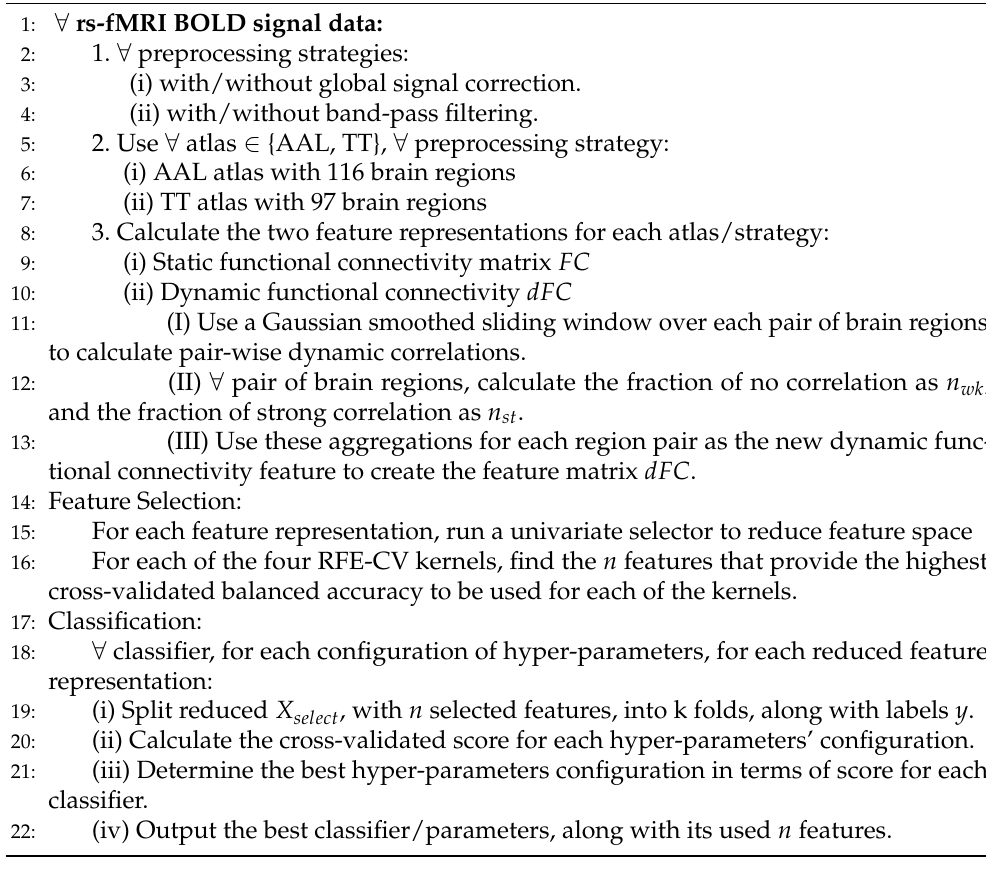
Algorithm 1 Step-by-step rs-fMRI diagnosis